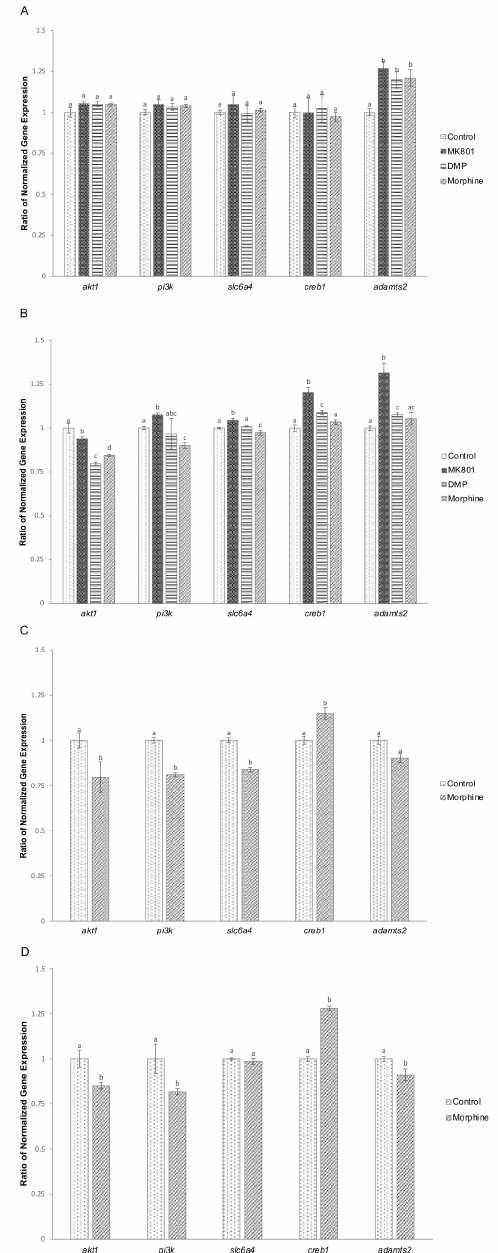
Figure 2. Altered gene expression in zebrafish larvae following exposure to MK801, DMP and mor- phine, and morphine withdrawal. ( A ) Effect of short-term (3-day) drug exposure on expression of akt1 (F (3,32) = 1.386, p = 0.265), pi3k (F (3,32) = 1.127, p = 0.299), slc64a (F (3,32) = 1.721, p = 0.182), creb1 (F (3,32) = 0.522, p = 0.667) and adamst2 (F (3,32) = 2.771, p = 0.058). ( B ) Effect of long-term (10-day) drug exposure on expression of akt1 (F (3,32) = 14.546, p < 0.001), pi3k (F (3,32) = 6.650, p < 0.001), slc64a (F (3,32) = 25.115, p < 0.001), creb1 (F (3,32) = 29.607, p < 0.001) and adamst2 (F (3,32) = 90.337, p < 0.001). ( C ) Effect of short-term morphine exposure followed by 5-day withdrawal on expression of akt1 ( t (16) = 8.945, p = 0.003), pi3k ( t (16) = 8.082, p = 0.001), slc6a4 ( t (16) = 5.591, p = 0.001), creb1 ( t (16) = 6.394, p = 0.001), adamts2 ( t (16) = 0.306, p = 0.064). ( D ) Effect of long-term mor- phine exposure followed by 5-day withdrawal on expression of akt1 ( t (16) = 8.945, p = 0.003), pi3k ( t (16) = 27.493, p < 0.001), slc6a4 ( t (16) = 2.445, p = 0.058), creb1 ( t (16) = 6.102, p < 0.001), adamts2 ( t (16) = 5.709, p = 0.001). Data expressed as mean ± SEM, n = 50 of 3 independent experiments. Different lowercase letters indicate statistically significant values, p < 0.05. DMP: